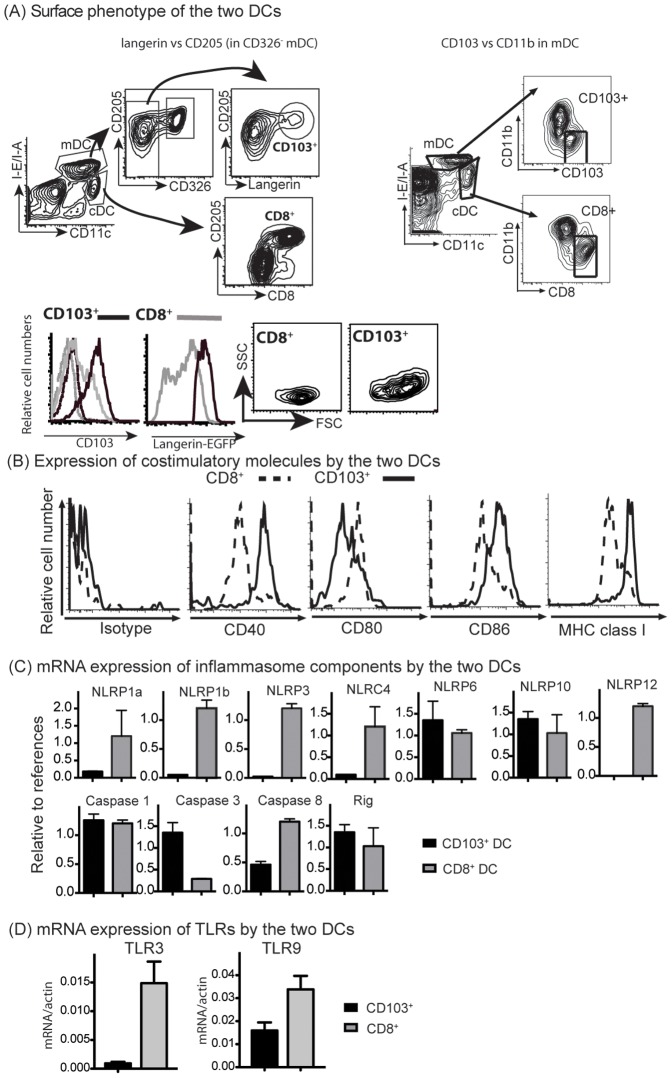
CD103+ DCs and CD8+ DCs differ in expression of costimulatory molecules, inflammasomes and TLR.(A) Cells of pooled cutaneous LNs from Langerin-EGFP mice and Langerin-EGFP/CD103−/− mice were analyzed. CD103+ DCs were identified as CD326−CD205+langerin+ within migratory DCs (mDC, CD11cintMHC IIhigh); CD8+ DCs were identified as CD205+ CD8+ within cDCs (CD11chighMHC IIint). Histograms show the expression of CD103 and langerin-EGFP by CD8+ and CD103+ DCs. For CD103 expression, CD8+ DCs (grey dot line) and CD205+CD11b− migratory DCs (equivalent of CD103+ DCs, black dot line) from CD103−/− mice were included. (B) CD8+ and CD103+ DCs from B6 mice were analyzed for the expression of costimulatory molecules. (C&D) CD8+ and CD103+ DCs from B6 mice were sorted. RT-qPCR was performed for the indicated transcripts with 3 reference genes as controls. One of three repeated experiments is shown.